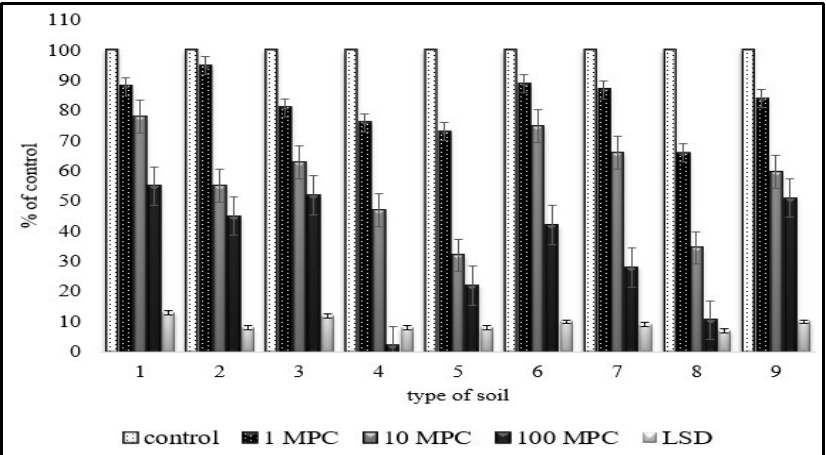
Figure 4. Changes in the cellulolytic activity of the forest soils: 1, brown leached soil; 2, brown typical soil; 3, brown carbonate soil; 4, yellow soil; 5, acid brown forest soil; 6, sod-carbonate typical soil; 7, leached sod-carbonate soil; 8. acid brown forest podzolized soil; 9, brown forest slightly unsaturated